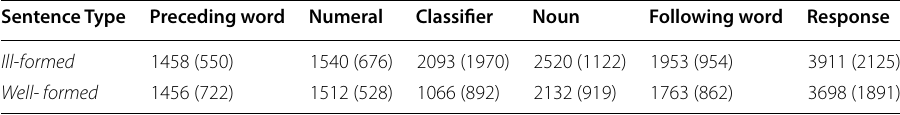
Table 4 Overall mean RTs for each region per sentence type Sentence Type Preceding word